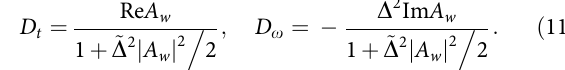
p e ), given by equations (13) and (15), are seen